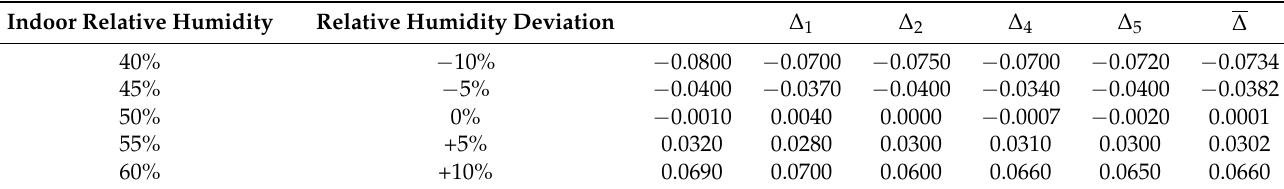
Table 5. PMV deviation with relative humidity deviation (compared to